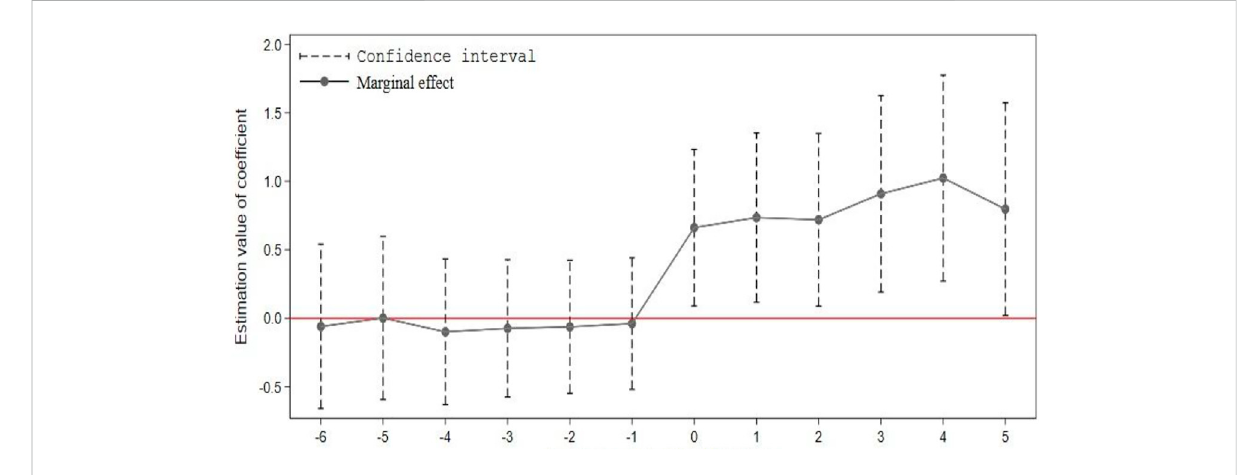
FIGURE 3 Dynamic effect of low-carbon city pilot policy.